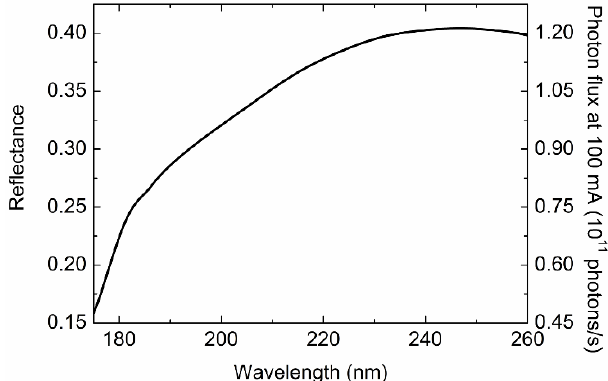
Figure 2. Light intensity of the focal unmonochromatized SR beam against the horizontal and vertical positions at the focal position. The collected data (open circle) were fitted by a Lorentz function (solid line).